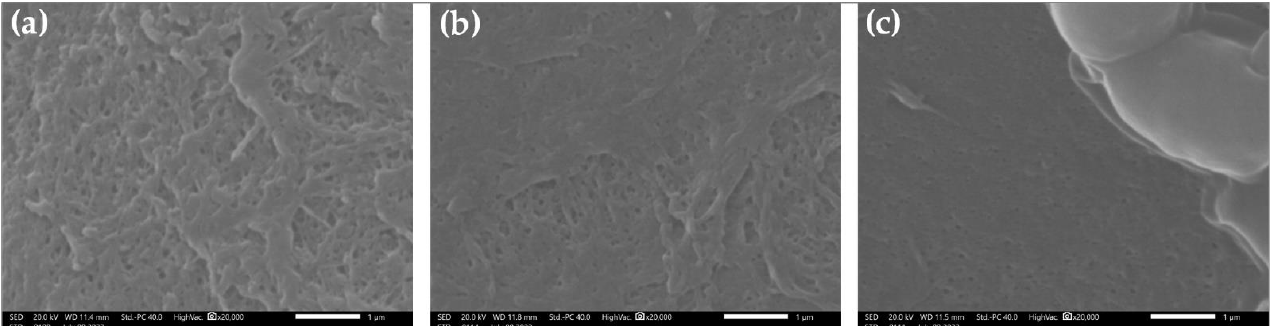
Figure 6. Scanning electron microscopy images of: ( a ) the pristine membrane; ( b ) the clean membrane after the 10th sterilization cycle; and ( c ) the same membrane after the fermentation filtration test. Samples from the feed and permeate were collected during fermentation broth filtra- tion tests for (OD 600 ) measurements. The mean OD 600 from the three filtration tests was 18.11 ± 0.80 for the feed, whereas for the permeate, OD 600 was 0.06 ± 0.00. This means